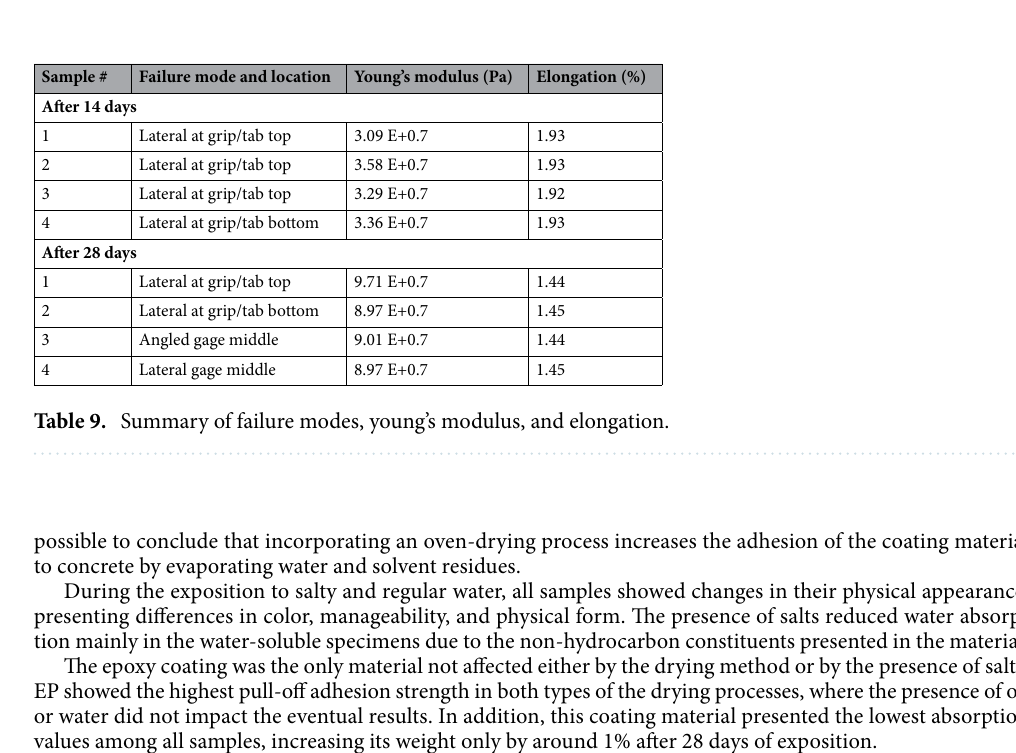
Figure 15. Detail failure mode and type: ( a ) Lateral at grip/tab Bottom ( b ) Lateral at grip/tab Top ( c ) Angled Gage Middle ( d ) Lateral Gage Middle.